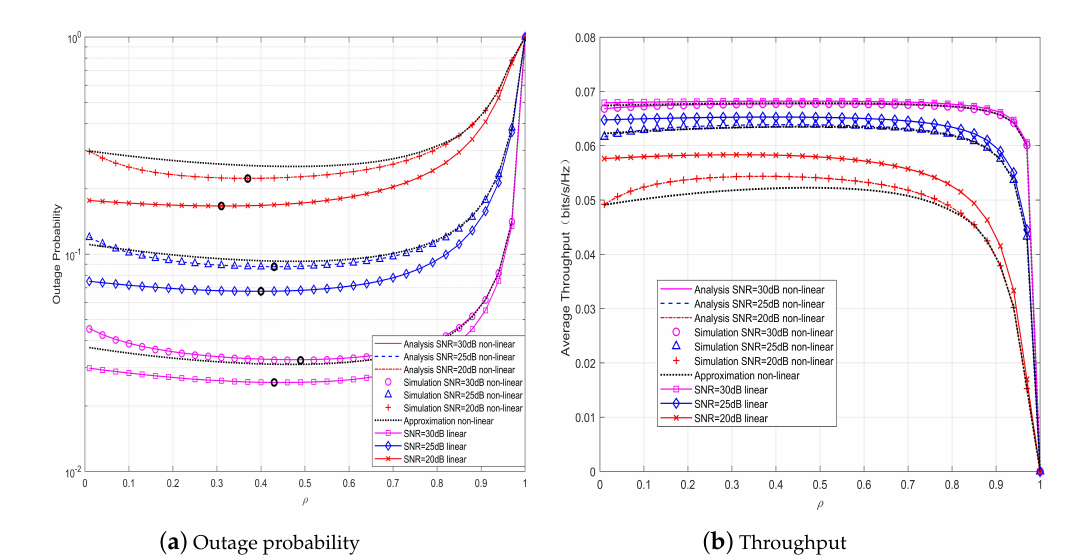
Figure 4. System performance versus ρ for various SNR when α = 0.3, d 1 = 2.2 m.